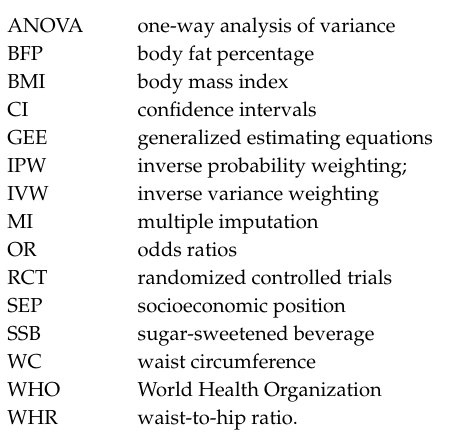
Figure S1: Participant flow chart in the “Children of 1997” Birth Cohort, Table S1: Characteristics of children with (n = 3628) and without (n = 4670) information on SSB consumption at 11 years in “Children of 1997” birth cohort, Table S2: Associations of SSB consumption at 11 years with BMI z-score, BMI centile and overweight (including obesity) from 12 to 18 years (complete case analysis), Table S3: Associations of SSB consumption at 11 years with WC, WHR and BFP at 16–19 years (complete case analysis), Table S4: Misclassification of SSB consumption at 11 years (complete case analysis), Table S5: Associations of composite SSB consumption at 11 and 13 years with BMI z-score and overweight from 12#x2013;18